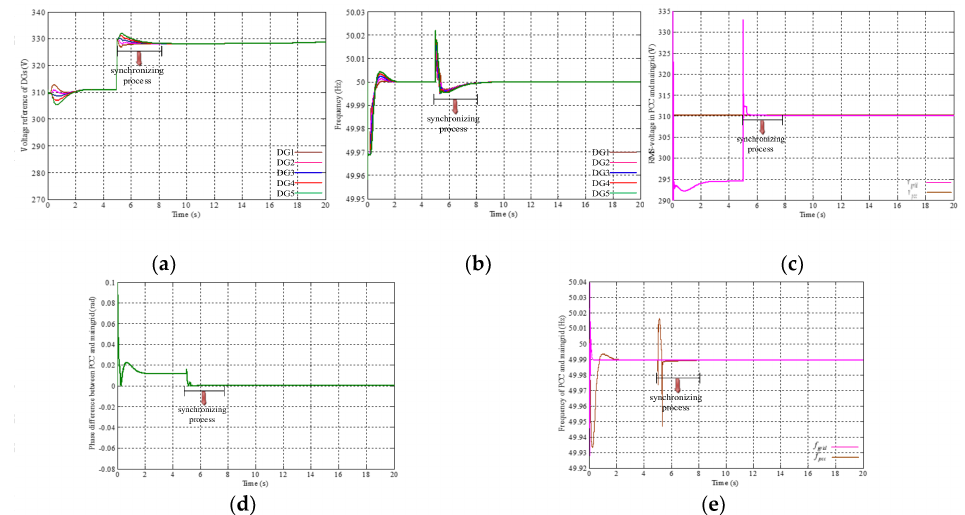
Figure 7. Simulation results of synchronizing mode. ( a ) Voltage reference of distributed generators (DGs). ( b ) Frequency of DGs. ( c ) Voltage of main grid and point of common coupling (PCC). ( d ) Phase angle difference of main grid and PCC. ( e ) Frequency of main grid and PCC.